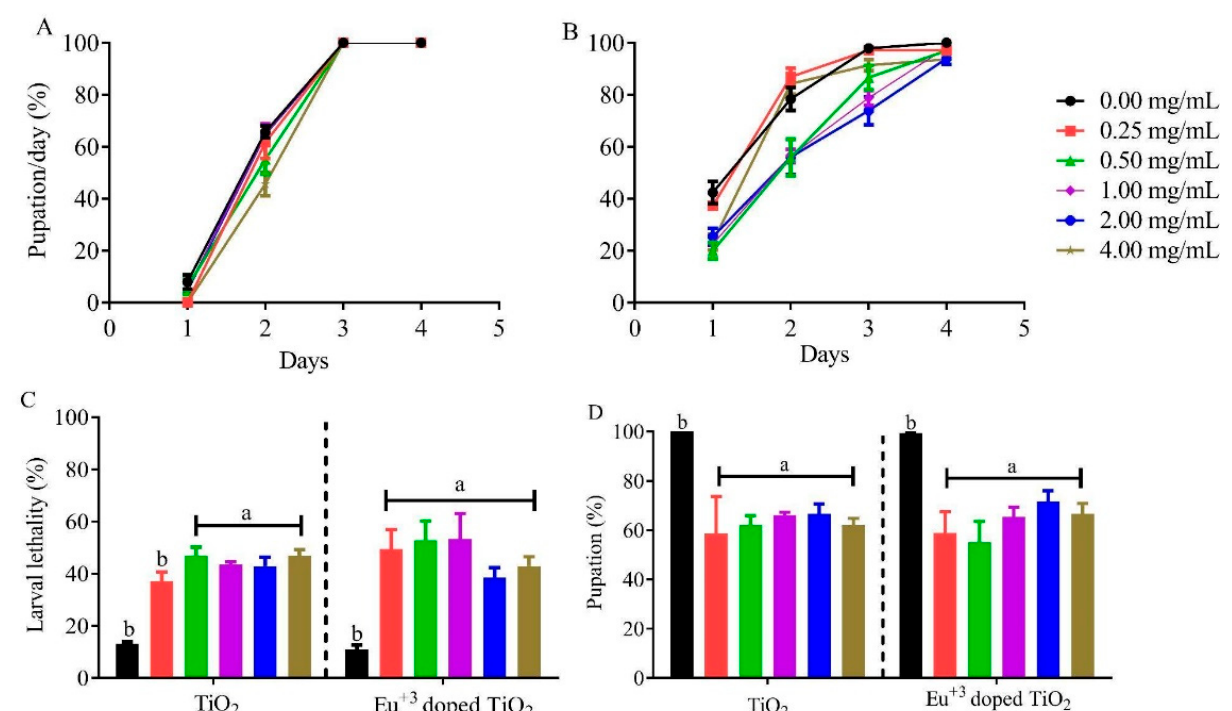
Figure 6. Larval exposure to TiO 2 and Eu 3+ -doped TiO 2 nanocrystals leads to high rates of larval lethality. Daily pupation analysis of Drosophila melanogaster following the exposure to ( A ) TiO 2 or ( B ) Eu 3+ -doped TiO 2 nanocrystals. Animals that developed in standard cornmeal medium supple- mented with TiO 2 only showed developmental delay at the higher concentration, while no delay was observed when larvae developed in Eu 3+ -doped TiO 2 . Data is represented as a geometric mean. T ( C ) The lethality rate and ( D ) pupation rate of Drosophila melanogaster when exposure to TiO 2 and Eu 3+ -doped TiO 2 nanocrystals. Data are represented as mean ± SEM.